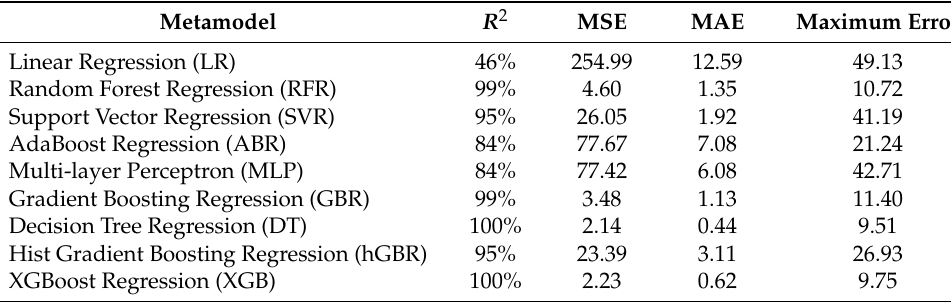
Table 3. Performance of the ML metamodels on testing data.